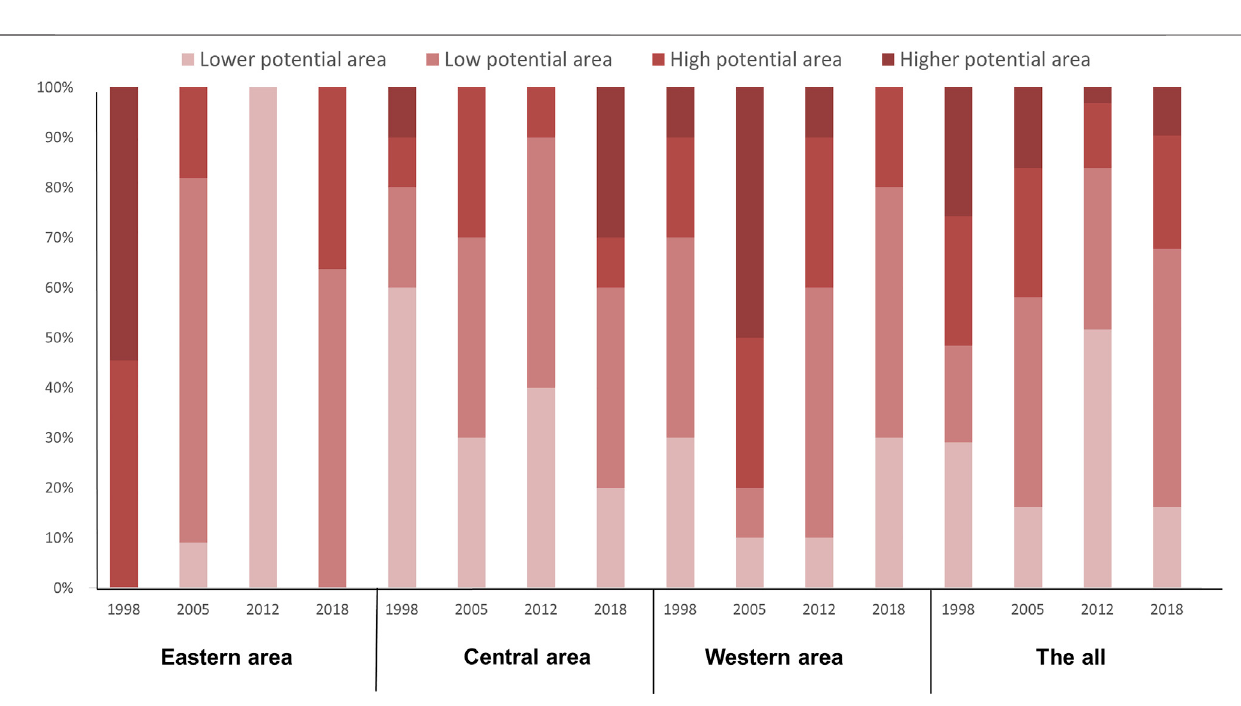
Frontiers in Energy Research |